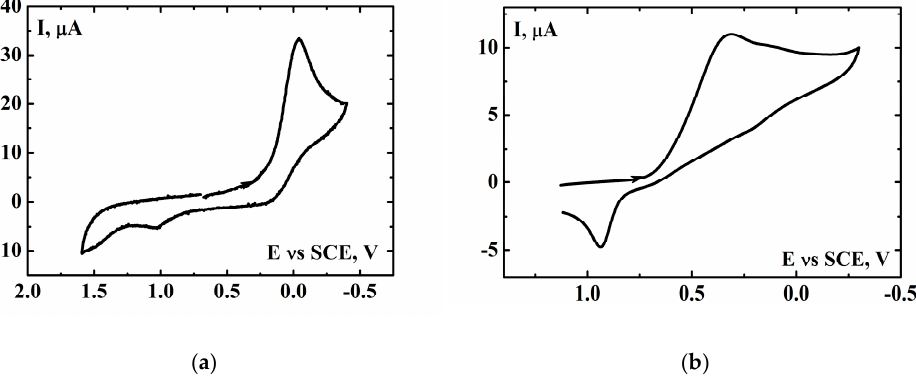
Figure 4. Cyclic voltammograms of ( a ) the mixture of 5mM [(N4Py)Fe II ] 2+ and 10 mM PhIO in MeCN [0.1 M ( t -Bu) 4 NClO 4 ] and ( b ) after the addition of 15 mM HClO 4 to the solution shown in ( a ). Scan rate, 0.1 V ∙ s − 1 , GCE (0.008 cm 2 ), SCE vs. NHE +0.242 V.